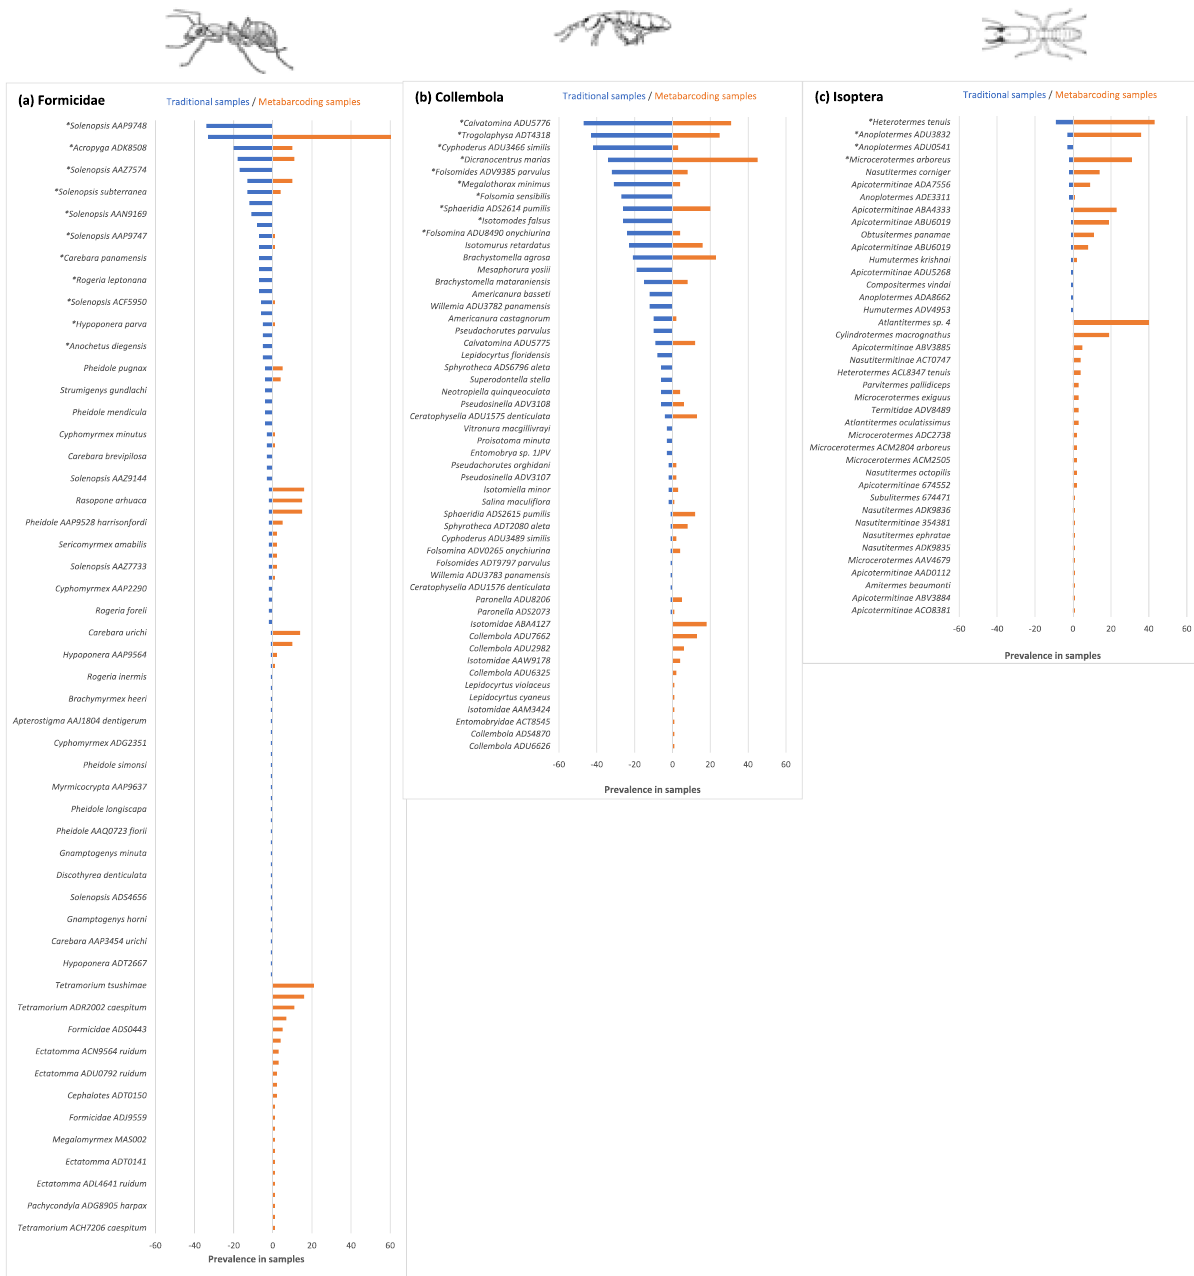
“*” represent common species as defined in this